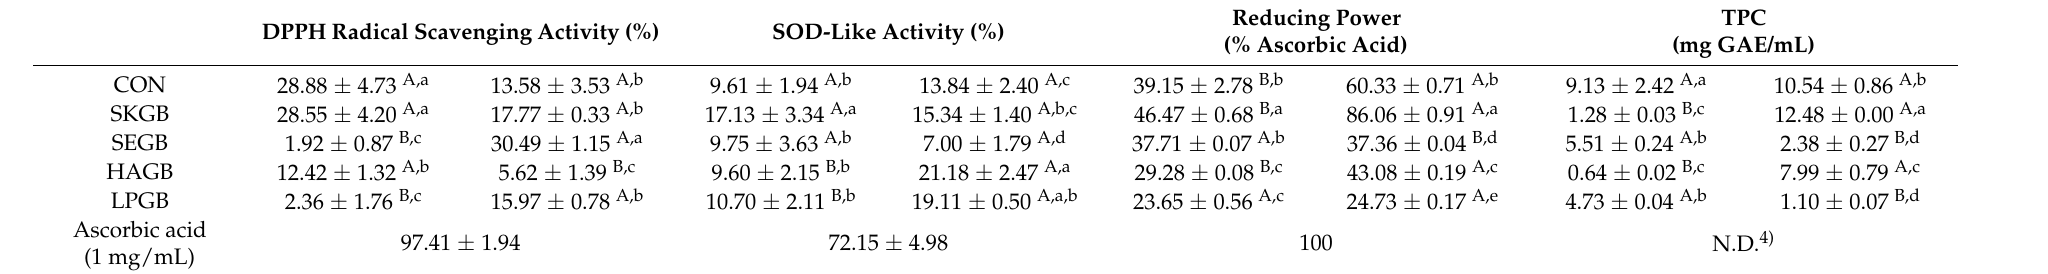
Table 4. Antioxidant activity and TPC of fermented GB before and after in-vitro